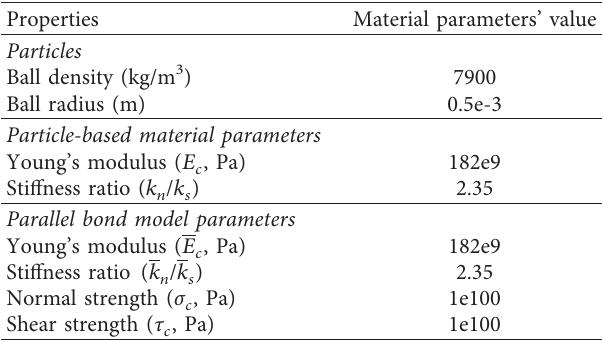
Table 2: Microscopic properties of particles and bonds of the SHPB